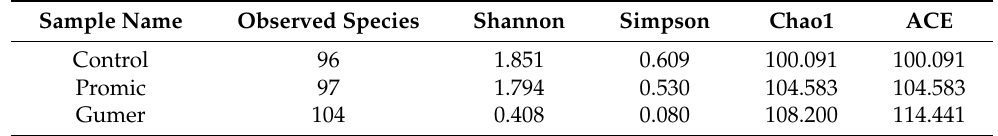
Table 2. Alpha diversity indices based on observed species.